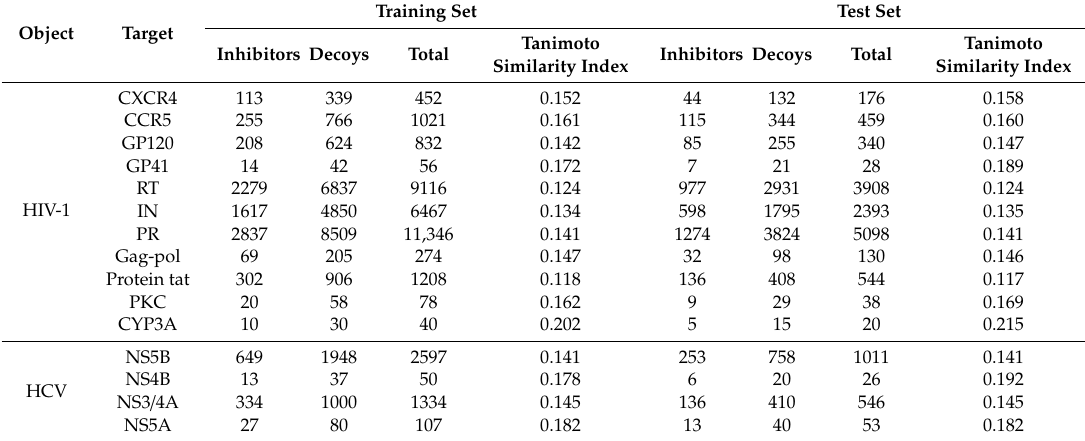
Table 1. Detailed statistical analysis of the 15 datasets.